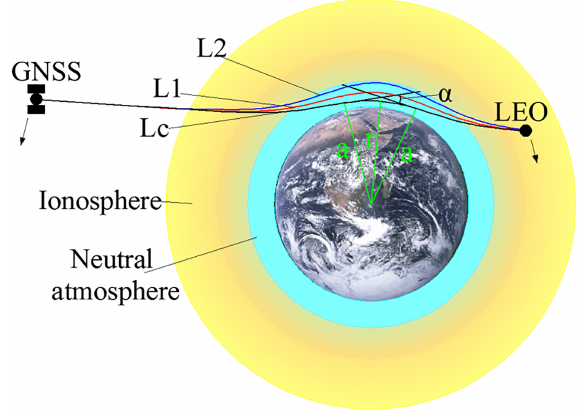
Figure 1. Radio occultation geometry between GNSS transmitter and low Earth orbit (LEO) receiver satellites, schematically illus- trating the separate L1 and L2 signal ray paths and the ionosphere- corrected (Lc) ray path through the atmosphere–ionosphere system. Key quantities additionally indicated are the (total accumulated) bending angle α , the (spherically symmetric) ray impact parame- ter a , and the radius r from the Earth’s center of curvature to the tangent point of the Lc signal path (modified from Liu et al.,